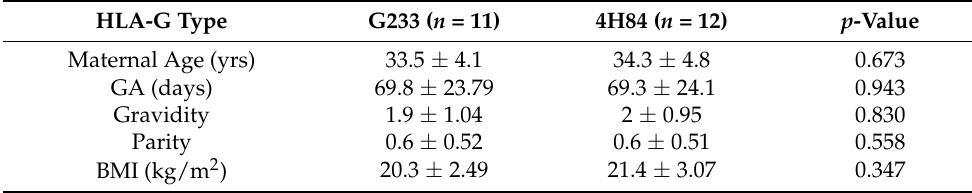
Table 1. Maternal basic characteristics according to HLA-G Ab type.